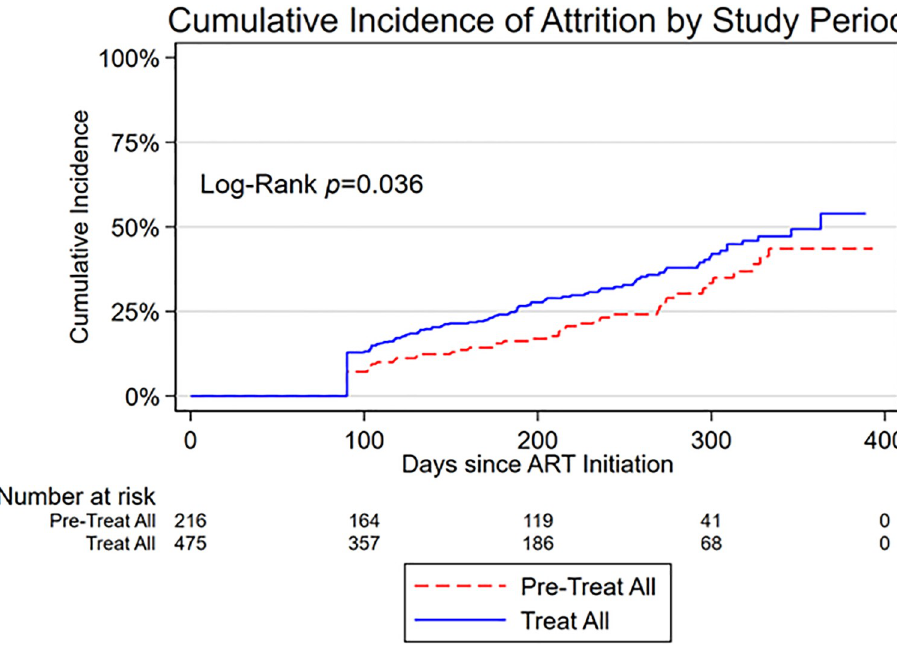
Fig 2. Cumulative incidence curve of attrition from HIV care by time period of enrolment into care (pre- treat-all versus treat-all) amongst adult patients following ART